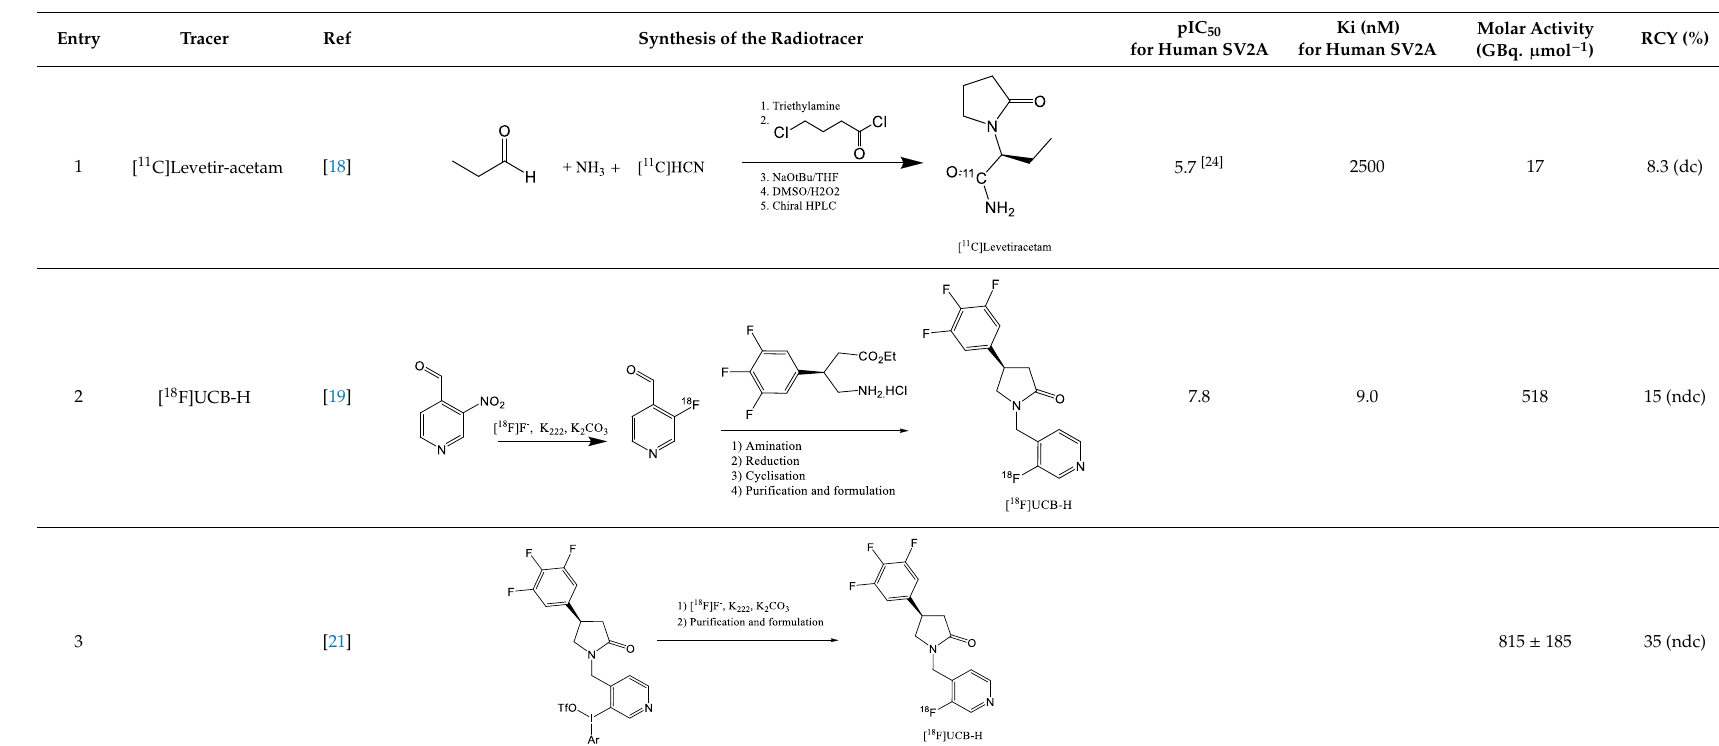
Table 1. Affinity, molar activity and radiochemical yield (RCY) of published SV2A tracers.